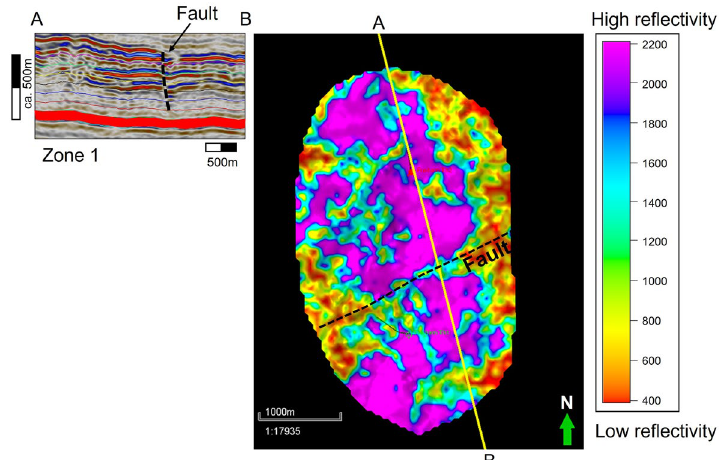
Fig. 11 Seismic attribute mapping per zone. The example shows the first results for zone 1, with high reflectivity in purple and low reflectivity in yellow/red colors. The high reflectivity correlates with the parallel high-amplitude seismic facies, which is interpreted as the well-bedded basin facies, and the low reflectivity correlated with the chaotic and subparallel low amplitude seismic facies. However, the cut-off between